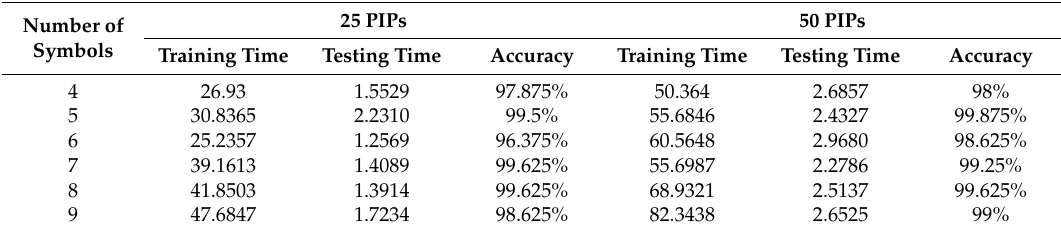
Table 6. Model’s performance with different number of